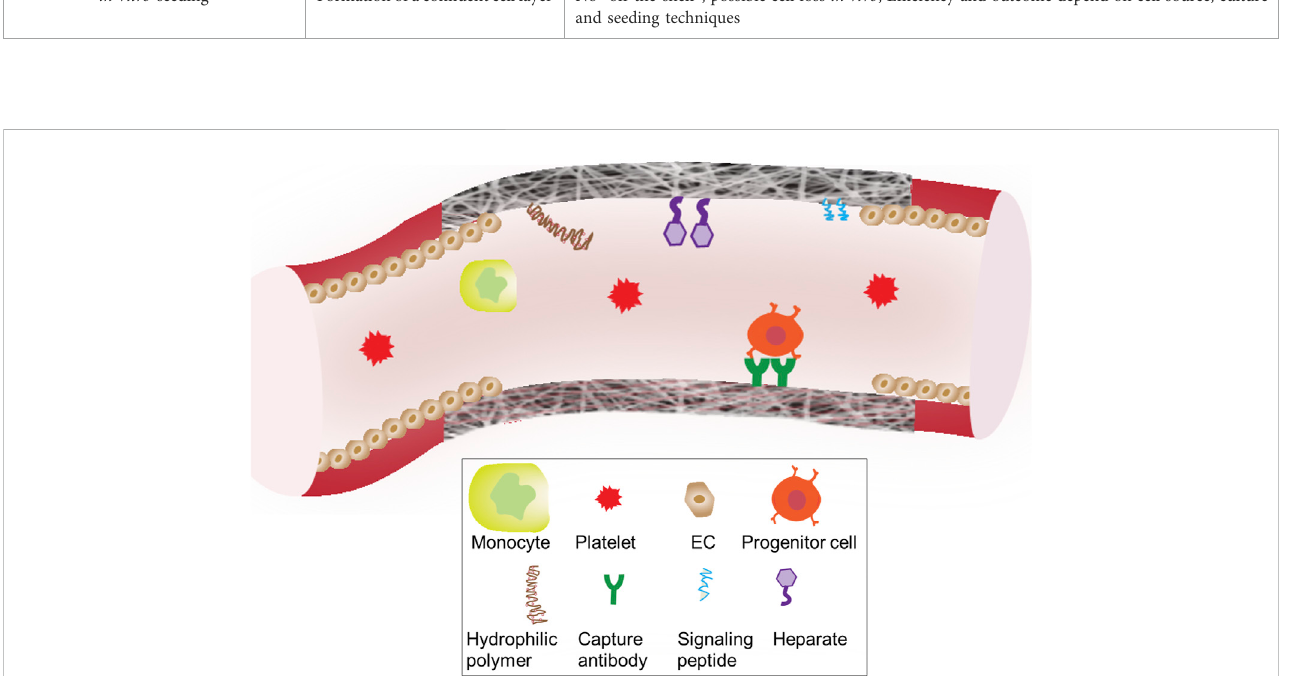
FIGURE 5 Surface engineering strategies of grafts Biomolecules conjugated to the surface graft materials are designed to interact with the blood components including blood cells, progenitor cells and platelets.